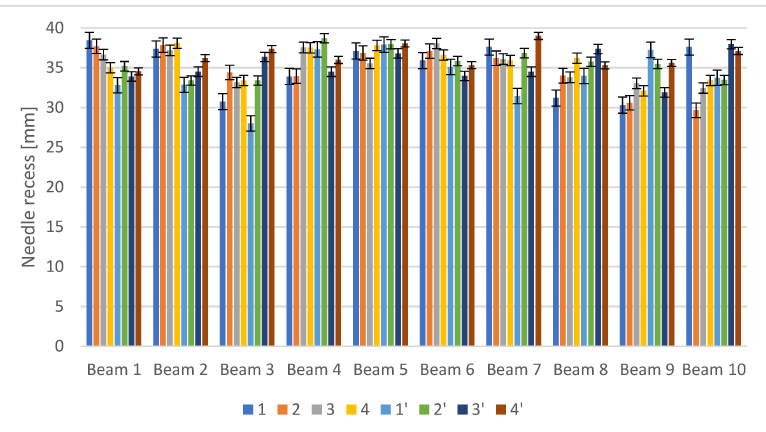
Figure 12. Needle recess from the head of pine wood beams. 1, 2, 3, 4, 1 (cid:48) , 2 (cid:48) , 3 (cid:48) , 4 (cid:48) —measurement points—the needle recess along